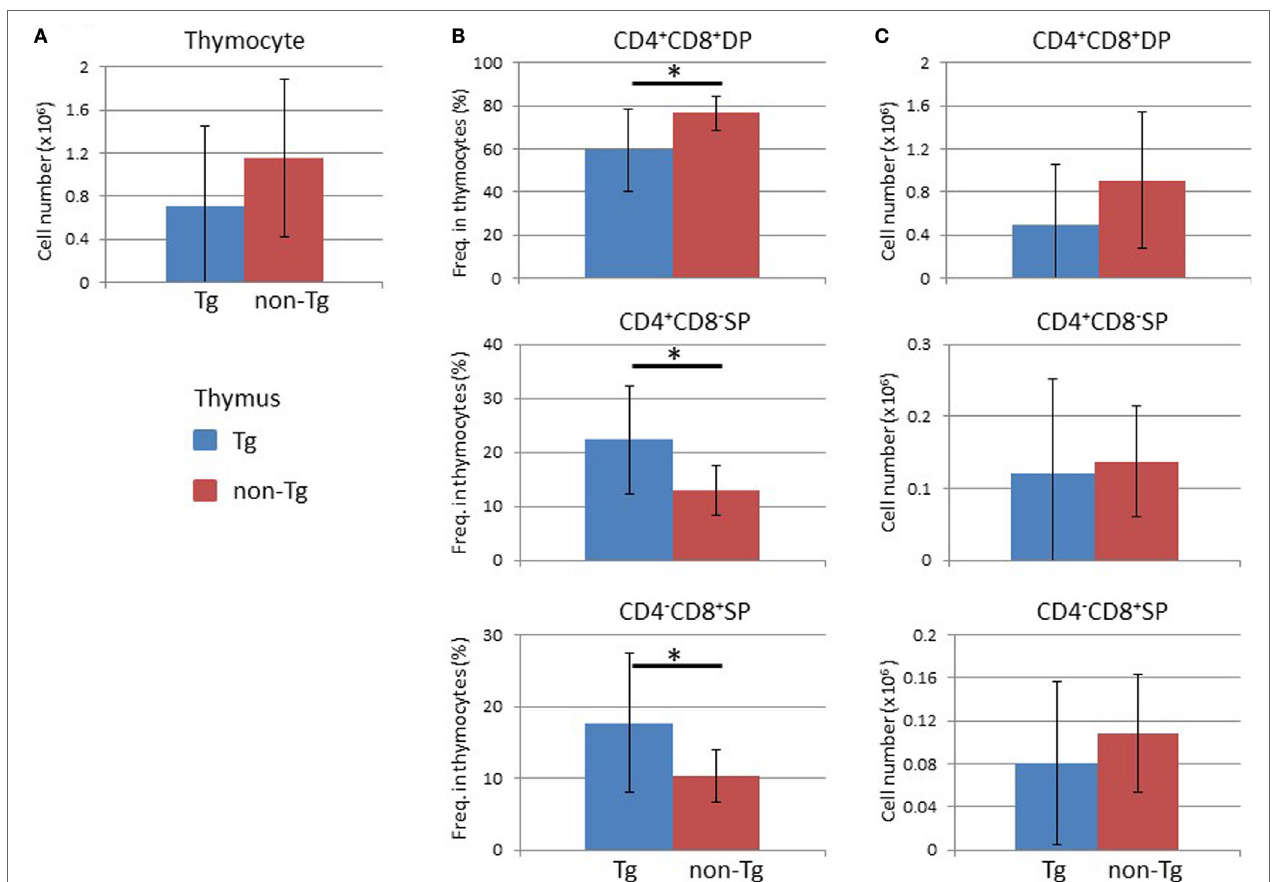
FigUre 5 | Analysis of human cells in the thymus. Thymocytes were prepared from the thymi of NOG-pROR γ t- γ c Tg and NOG non-Tg mice at 24 weeks after hematopoietic stem cell transplantation and analyzed by fluorescence-activated cell sorting. (a) Absolute numbers of human thymocytes. (B,c) The frequencies of human CD4 + CD8 + double positive, CD4 + CD8 − , and CD4 − CD8 + single positive cells in human thymocytes (B) and the absolute numbers of each cell subpopulation (c) . Mean ± SD of NOG-pROR γ t- γ c Tg ( n = 12) and NOG non-Tg mice ( n = 11). Asterisk indicates statistical significance ( p <